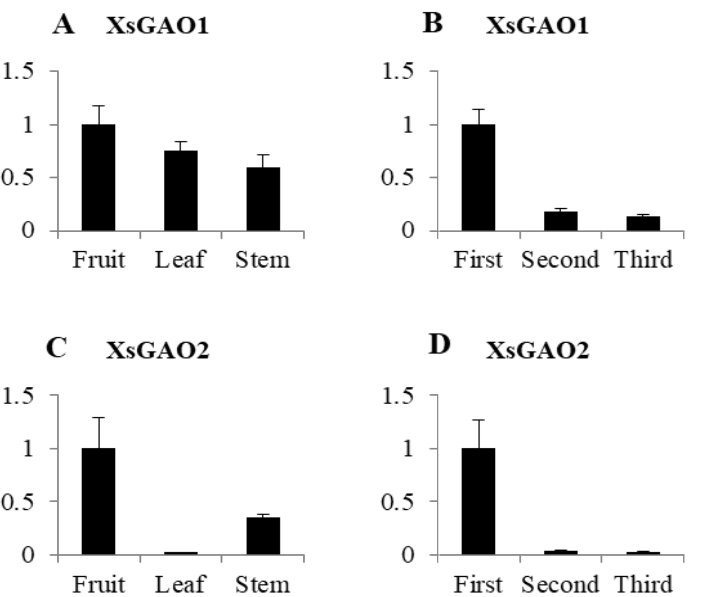
Figure 4. Expression of Xs GAO1 and Xs GAO2 in different organizations and periods (( A , C ) are the expressions in different organs; ( B , D ) are the expressions at different times).